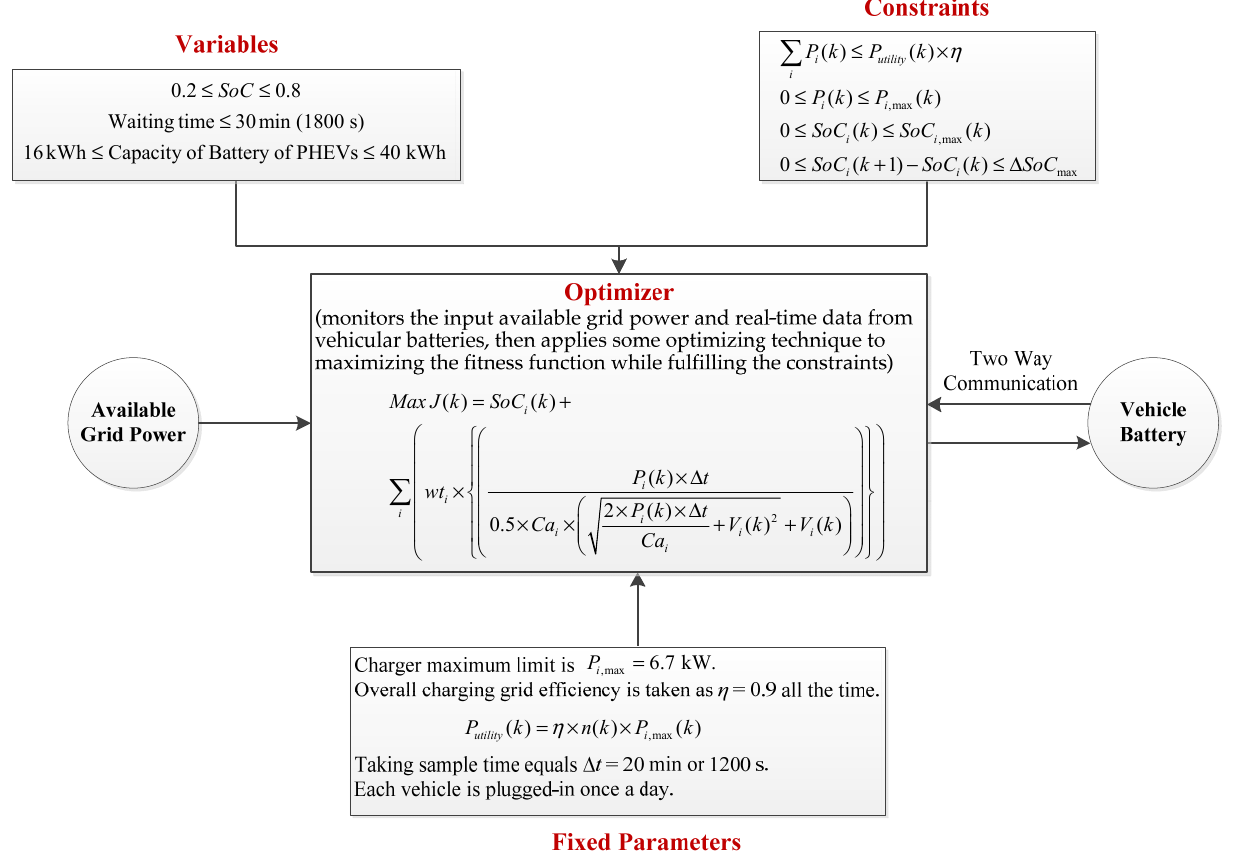
Figure 3. Problem statement description by the fl ow